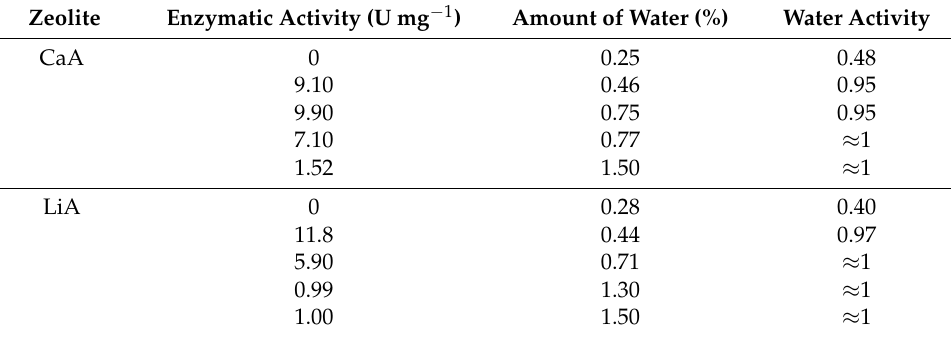
Table 1. Enzymatic activity, amount of water and water activity for zeolites A according to their associated cation. Higher enzymatic activity in bold